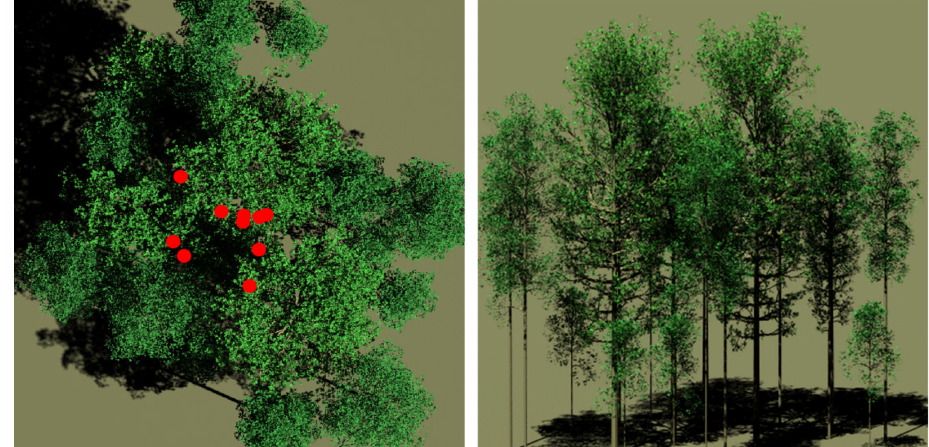
Figure 13. Images of maple and oak grove from directly overhead, ( left ), and from the side, ( right ). Red scatter points are displayed on the overhead image at locations where the canopy was